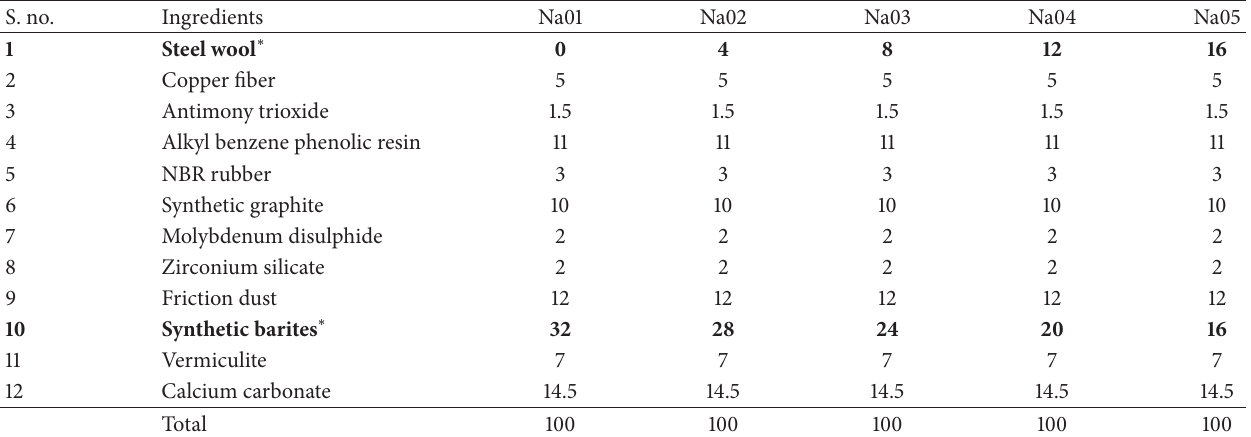
Table 2: List of the ingredients in composites by weight percentage.